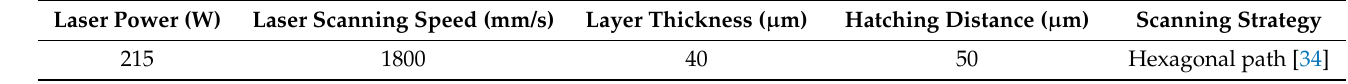
Table 1. SLM manufacturing